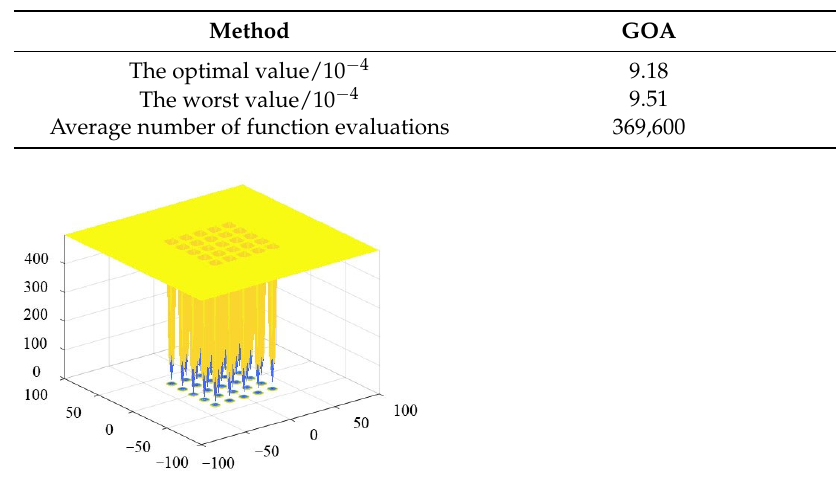
Figure 6. Three ‐ dimensional space surface diagram of Case 2.